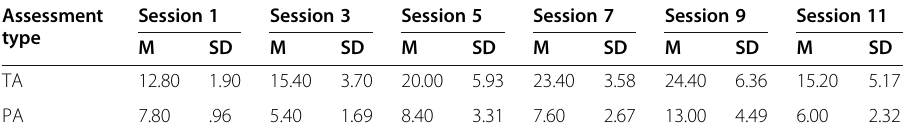
Table 5 Descriptive statistics of TA and PA on descriptive writings Assessment